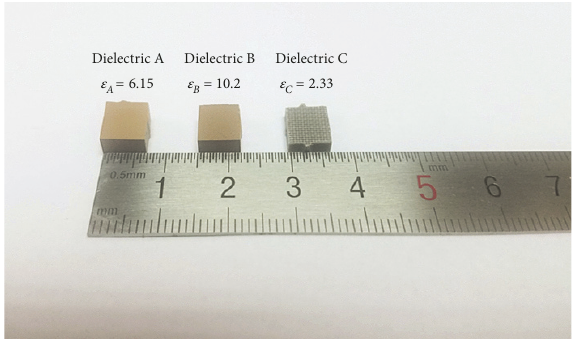
Figure 2: Prototype of three dielectric